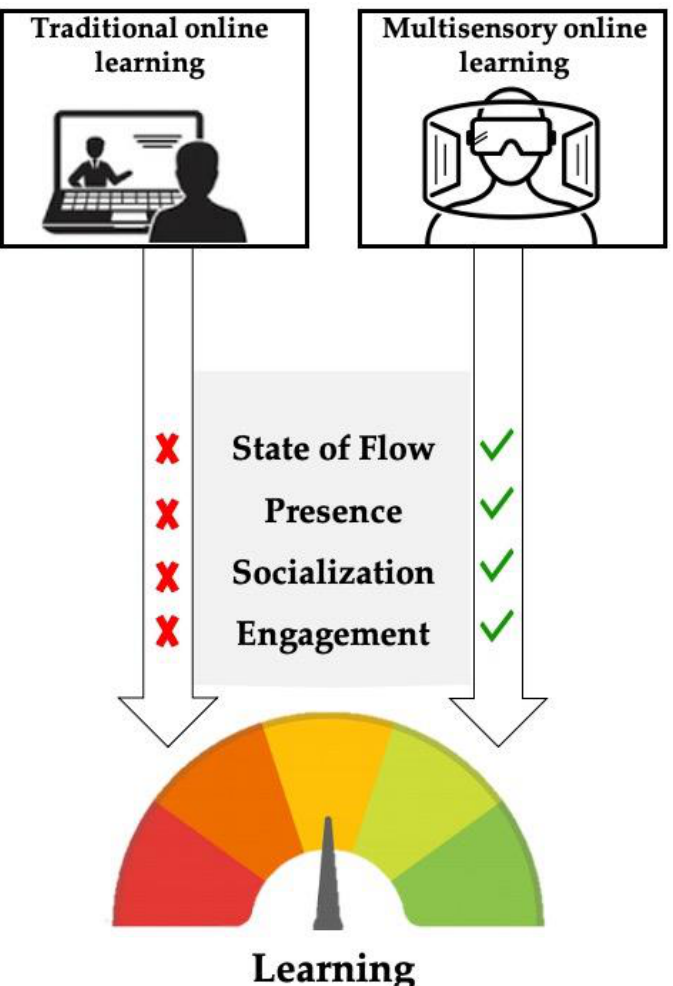
Figure 1. Schematic flow chart of the online learning process. On the left: traditional online learning prevents the reaching of learning bedrocks, thus leading to learning impairment. On the right: multisensory online learning allows the reaching of learning bedrocks, thus leading to learning empowerment.